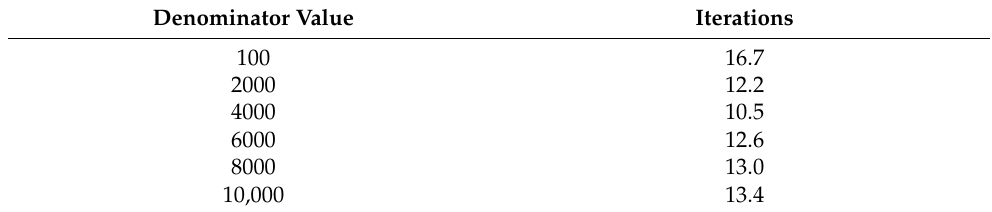
Table 3. Average number of iterations for denominator variable (i.e., den) in Algorithm 1. Denominator Value